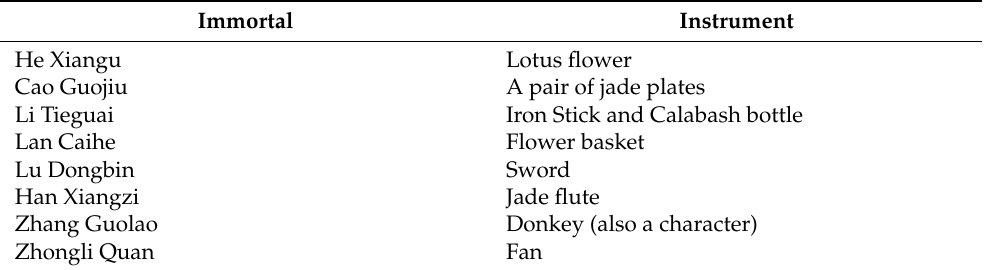
Table 3. Instruments of the Eight